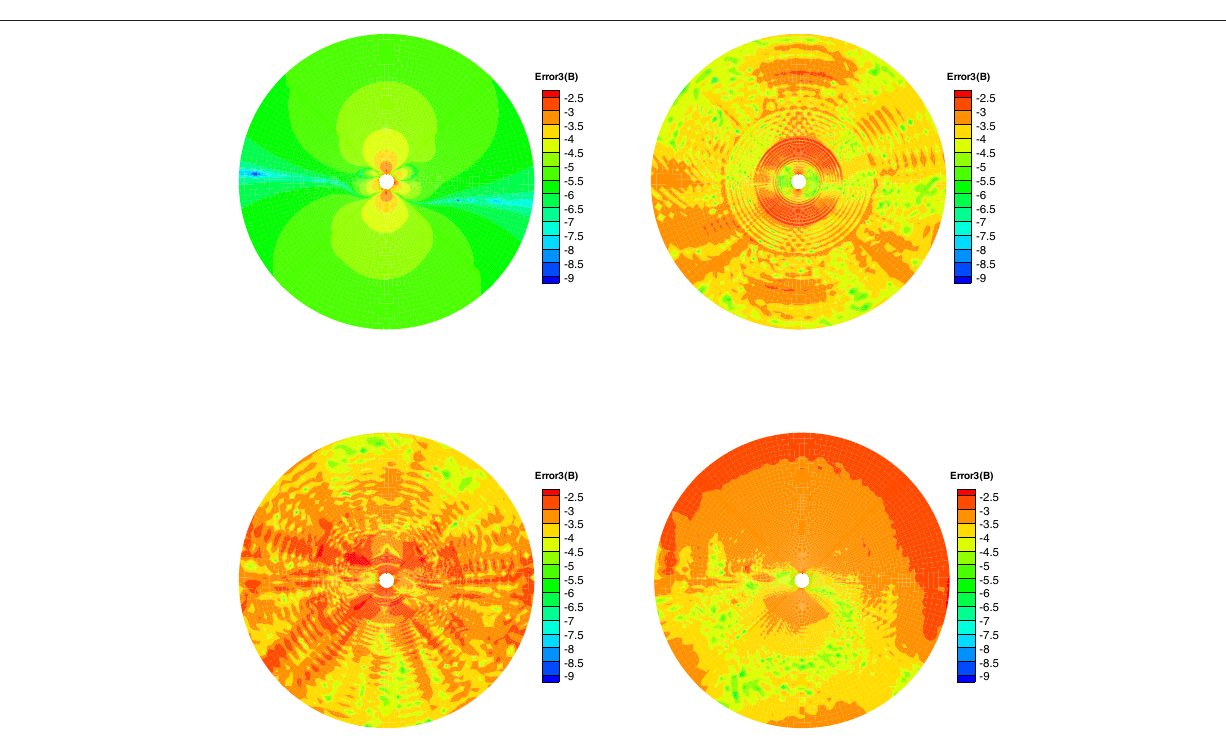
Frontiers in Astronomy and Space Sciences |